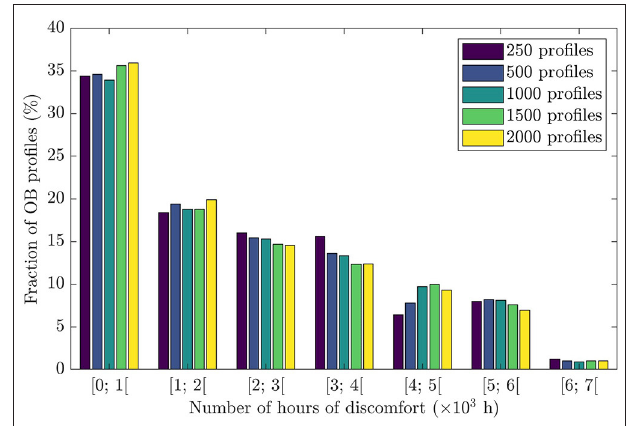
FIGURE 2 | Impact of N , the number of occupant behavior (OB) profiles, on the probability distribution of the number of hours of discomfort.